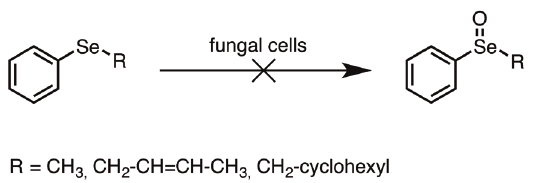
Figure 42 - Incubation of a series of phenyl selenides with Aspergillus niger, Aspergillus foetidus, Mortierella isabellina and Helminthosporium sp.